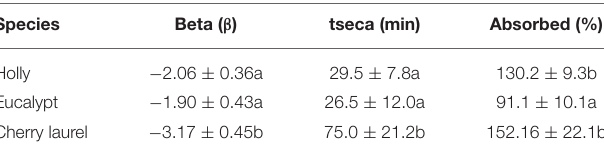
Data are means ± SD (n = 30). Within columns for the same species, values marked with different letters are significantly different according to Tukey’s HSD test (P ≤ 0.05).